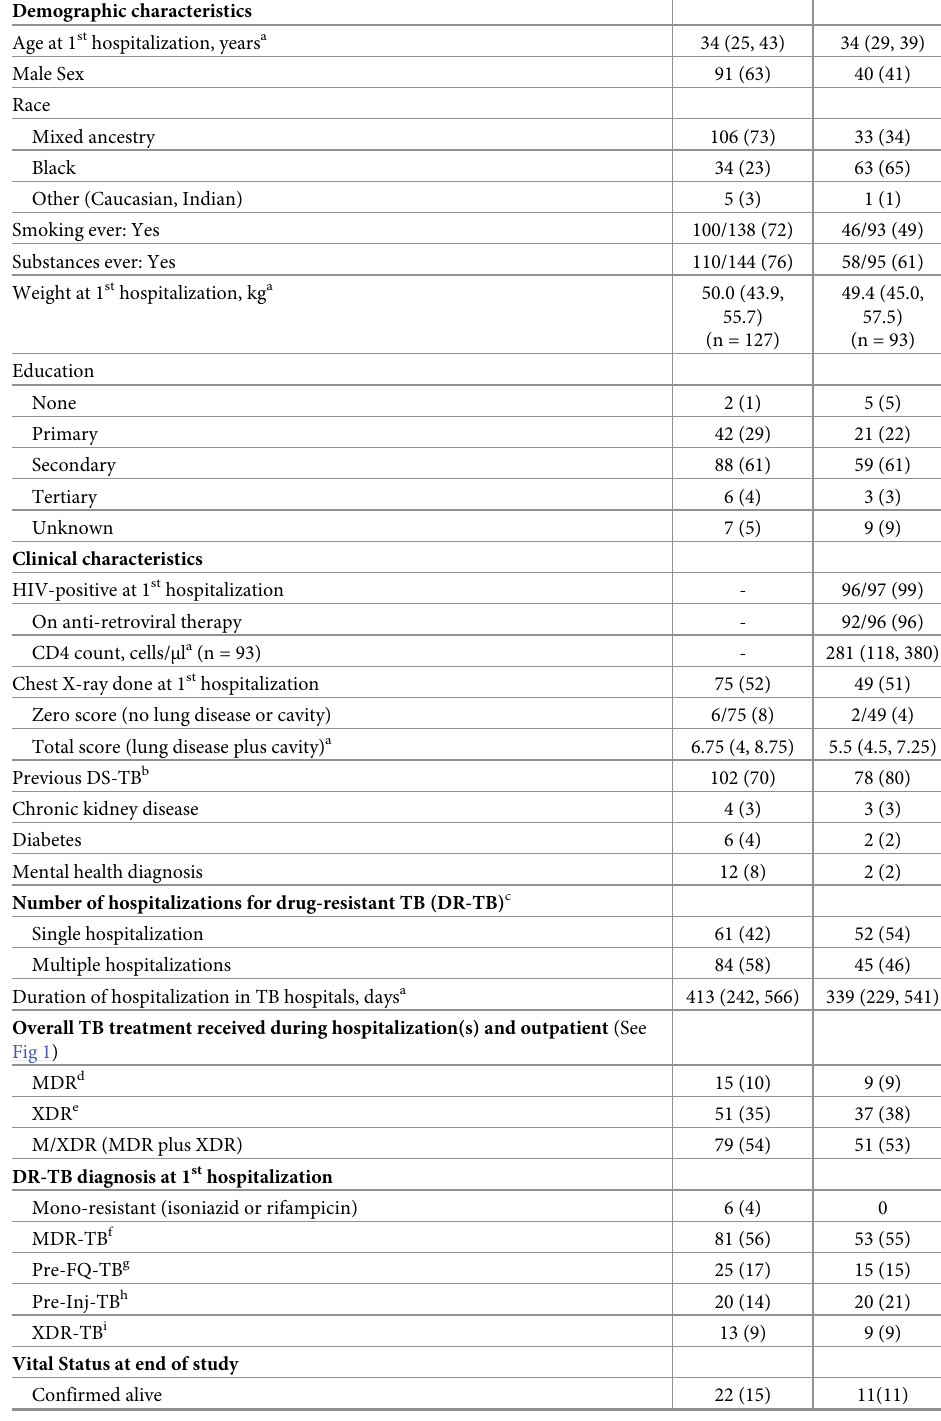
Table 1. Patient characteristics. Characteristics of 242 hospitalised drug-resistant tuberculosis patients stratified by HIV status. Data are median (interquartile range) or n/N (%) unless otherwise